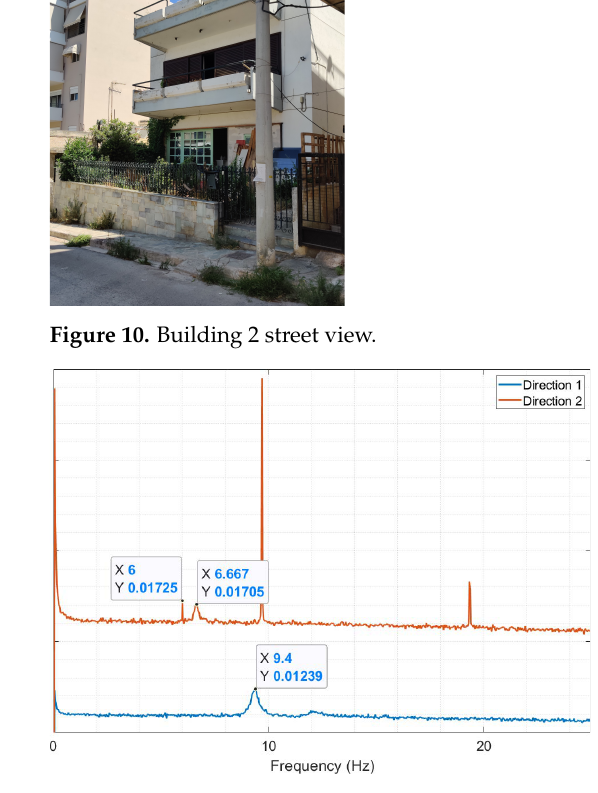
Figure 11. Building 2: Average FFT magnitude for each direction.